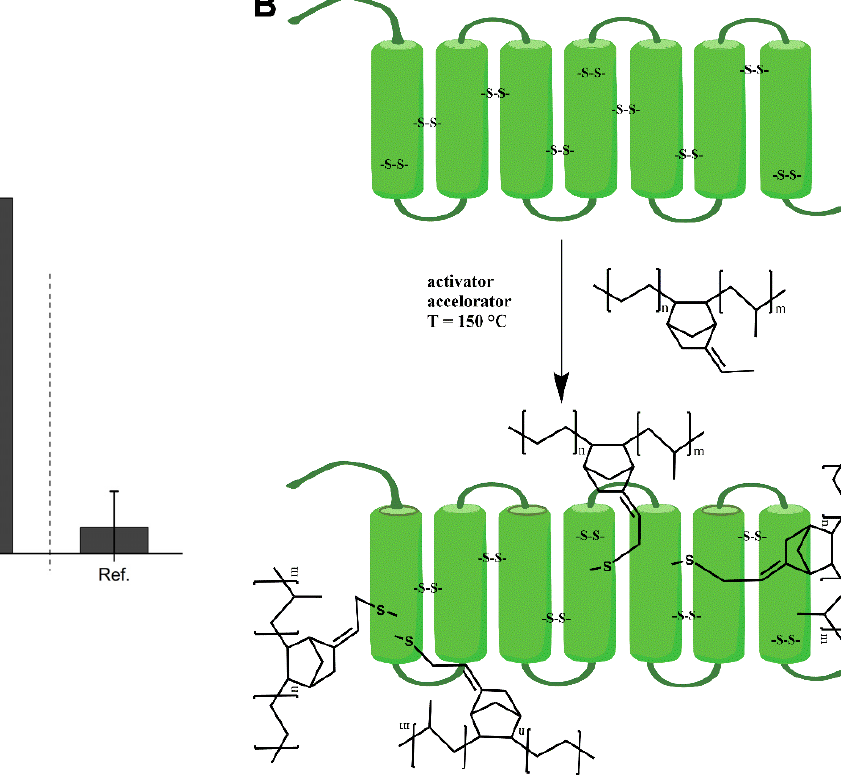
Figure 8. ( A ) Amount of non-extractable material after 72 h of Soxhlet extraction with toluene. Samples were prepared with 100 phr of feathers in three lengths using the EPDM mixture M2 without sulphur. A vulcanised M2 mixture without feathers and sulphur is used as reference. ( B ) Schematic illustration of the cross-linking of EPDM rubber with keratin.